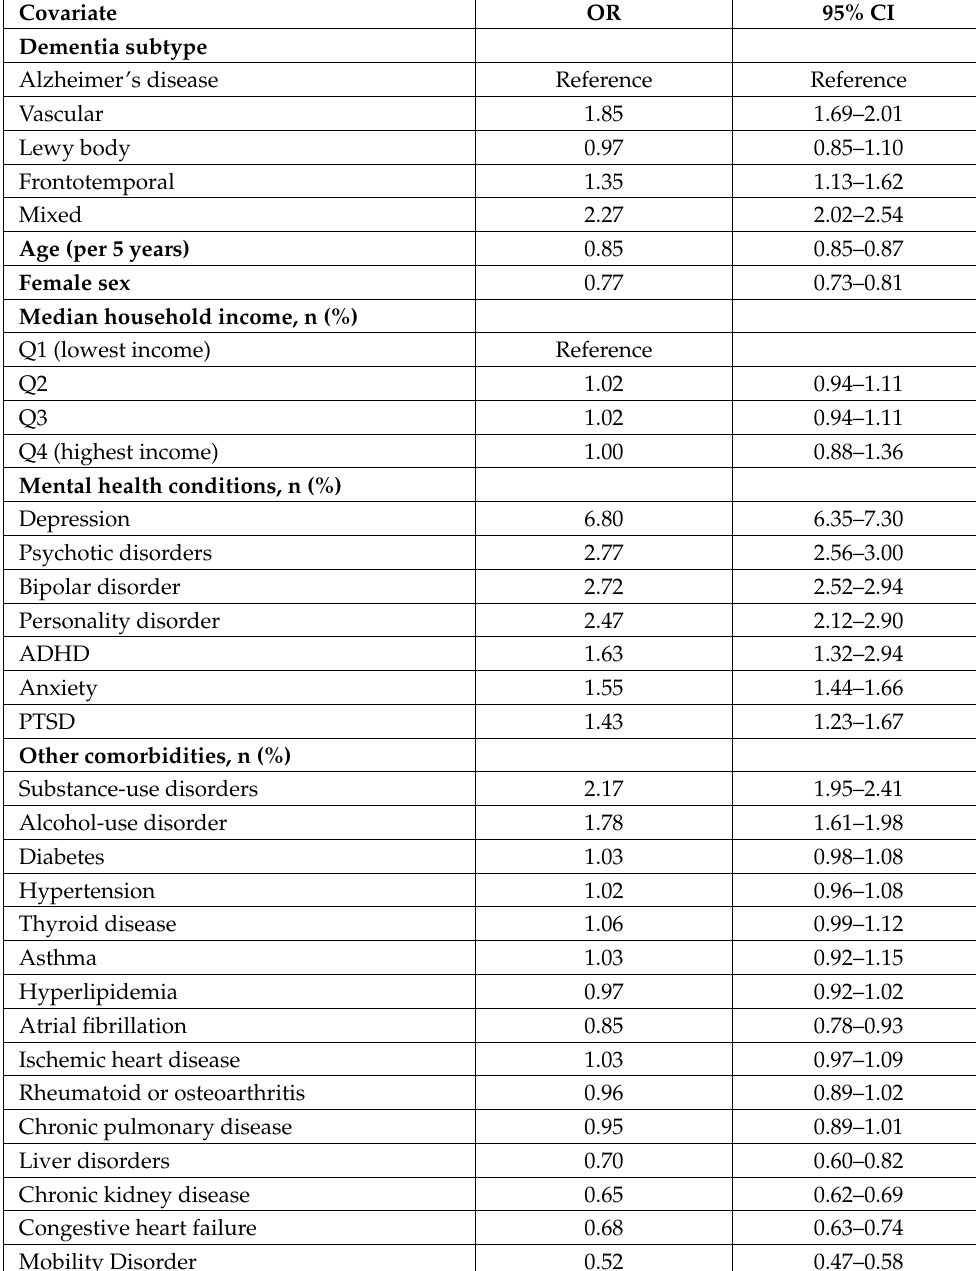
Table 2. Association of patient demographic and clinical characteristics with suicidal behaviors among people with Alzheimer’s disease and related dementia